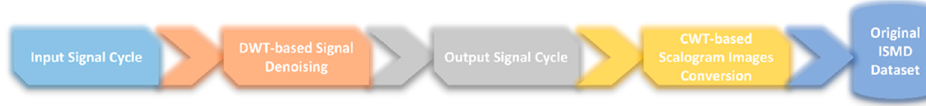
Figure 10. Flow of signal processing and data dimension conversion technique.